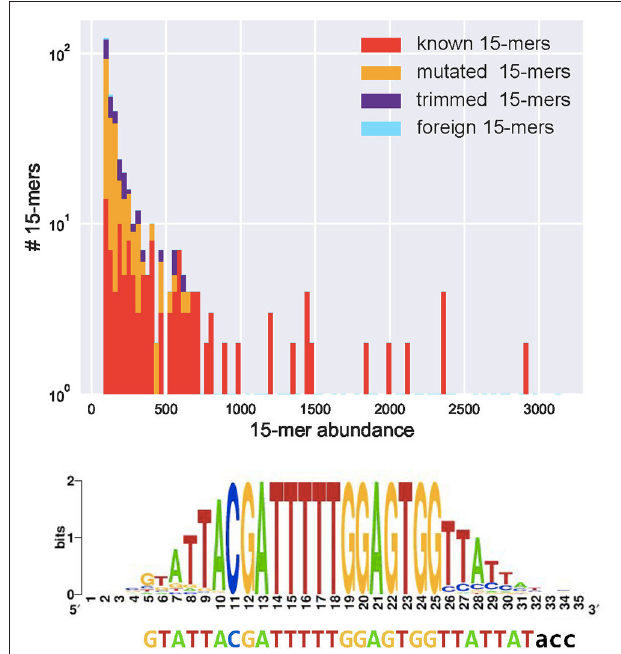
FIGURE 1 | Abundances of all 443 common 15-mers (top) and the motif logo constructed for the most abundant 15-mer CGATTTTTGGAGTGG in the CDR3 * dataset constructed from the Set 1 dataset (bottom) . (Top) The CDR3 * dataset contains 91% of all 15-mers appearing in human D genes (all 15-mers in human D genes are unique, i.e., appear in a single D gene). Four hundred forty-three common 15-mers in the CDR3 * set have abundances varying from 83 to 3,141. The y –axis represents the number of common 15-mers with given abundance (in logarithmic scale). Red, yellow, violet, and blue bars represent the number of common 15-mers with given abundance among known, mutated, trimmed, and foreign 15-mers, respectively. There exist 175 known, 195 mutated, 70 trimmed, and three foreign common 15-mers. The histogram represents 100 bins of width 30 each. (Bottom) The ATTACGATTTTTGGAGTGGTTAT is the initial 28-nucleotide long sequence formed by positions in the motif logo with high information content (37). The motif logo was constructed using 3,141 sequences from the set CDR3 * containing the most abundant k -mer. After extending this 28-mer, IgScout reconstructed the 30-mer GTATTACGATTTTTGGAGTGGTTATTAT that is a substring of the 33-nucleotide long IGHD3-3 gene GTATTACGATTTTTGGAGTGGTTATTAT acc shown below the